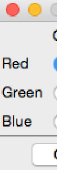
ues of the two equatorial coordinates: right ascension and declination. The CD values correspond to a ma- trix mapping the two coordinate systems to each other. Often, the axes of the WCS and the image coordinate systems are parallel to each other. (You can check this in the overview window in the upper right corner, sec- ond from the right, where the North and East directions are shown as N and E, and the image coordinate direc- tions as X and Y.) In that case, CD1 2 and CD2 1 are zero, and for the usual square pixels, CD1 1 and CD2 2 are equal (up to a sign) and denote the image scale. In our case, CD2 2 = 2.777777777777778E-05 denotes the degrees that correspond to the width of a single pixel; 2 . 7 · 10 − 5 degrees per pixel corresponds to 0 . 1 arc sec- onds per pixel. CD1 1 has an extra minus sign because the X direction and the East direction are anti-parallel in this image.